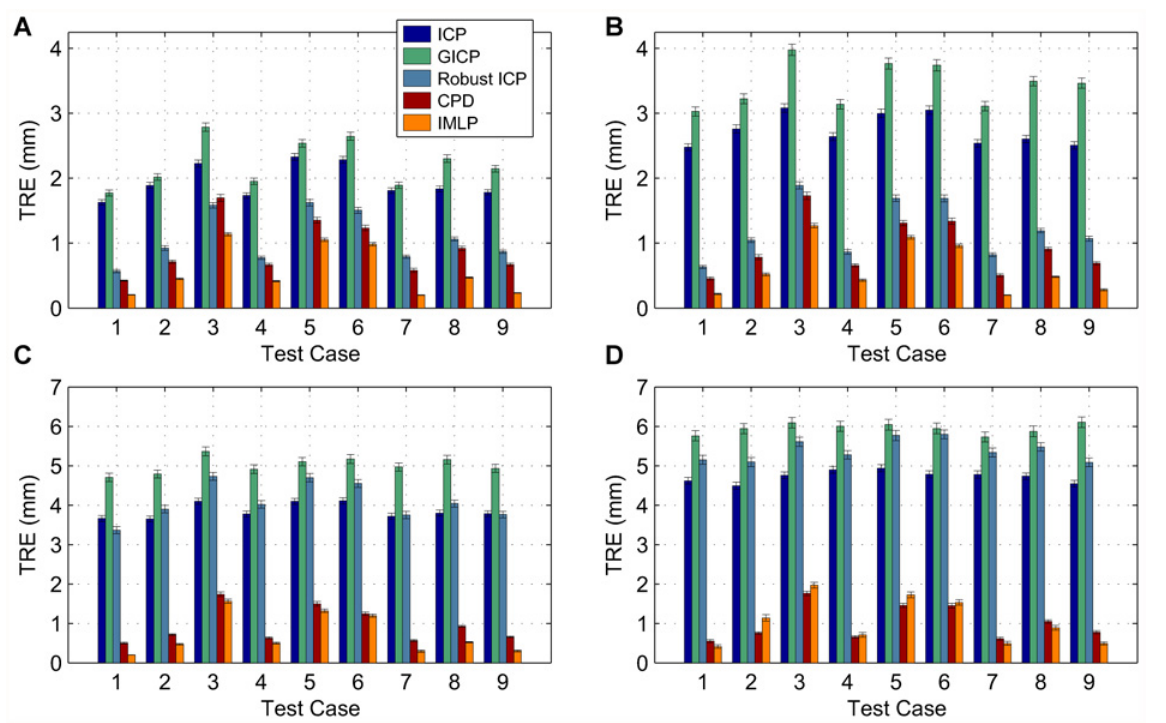
Fig 7. Registration errors for registering a source shape containing outliers to a point-cloud target under large misalignment. (Experiment 5B). Source shapes were randomly generated from a mesh model of a human hip (Fig. 1A), misaligned by [30, 60] mm / degrees, and registered back to a point- cloud representation of the mesh. The test cases represent different noise models used to generate noise on the source shape (Table 4). Outliers were added to the source shape constituting (A): 5%, (B): 10%, (C): 20%, and (D): 30% of the source points. For each test case, 300 randomized trials were conducted, with successful registrations being used to compute an average target registration error (TRE). The error bars provide approximate standard deviations of the reported average TRE values. The proposed IMLP algorithm was evaluated relative to standard ICP [1], GICP [11], a robust variant of ICP [4], and CPD